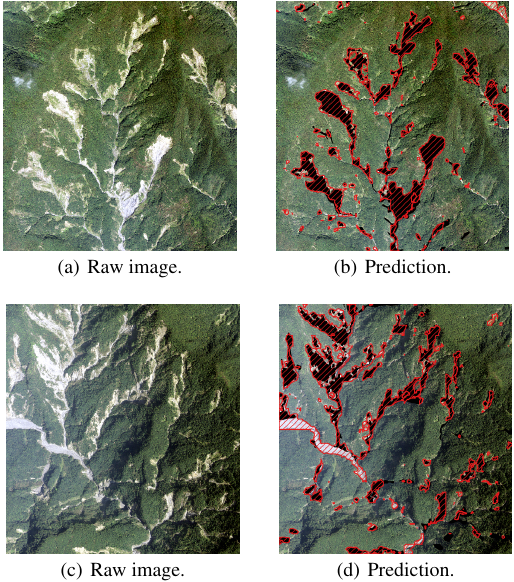
Figure 13. Landslide segmentation prediction results.